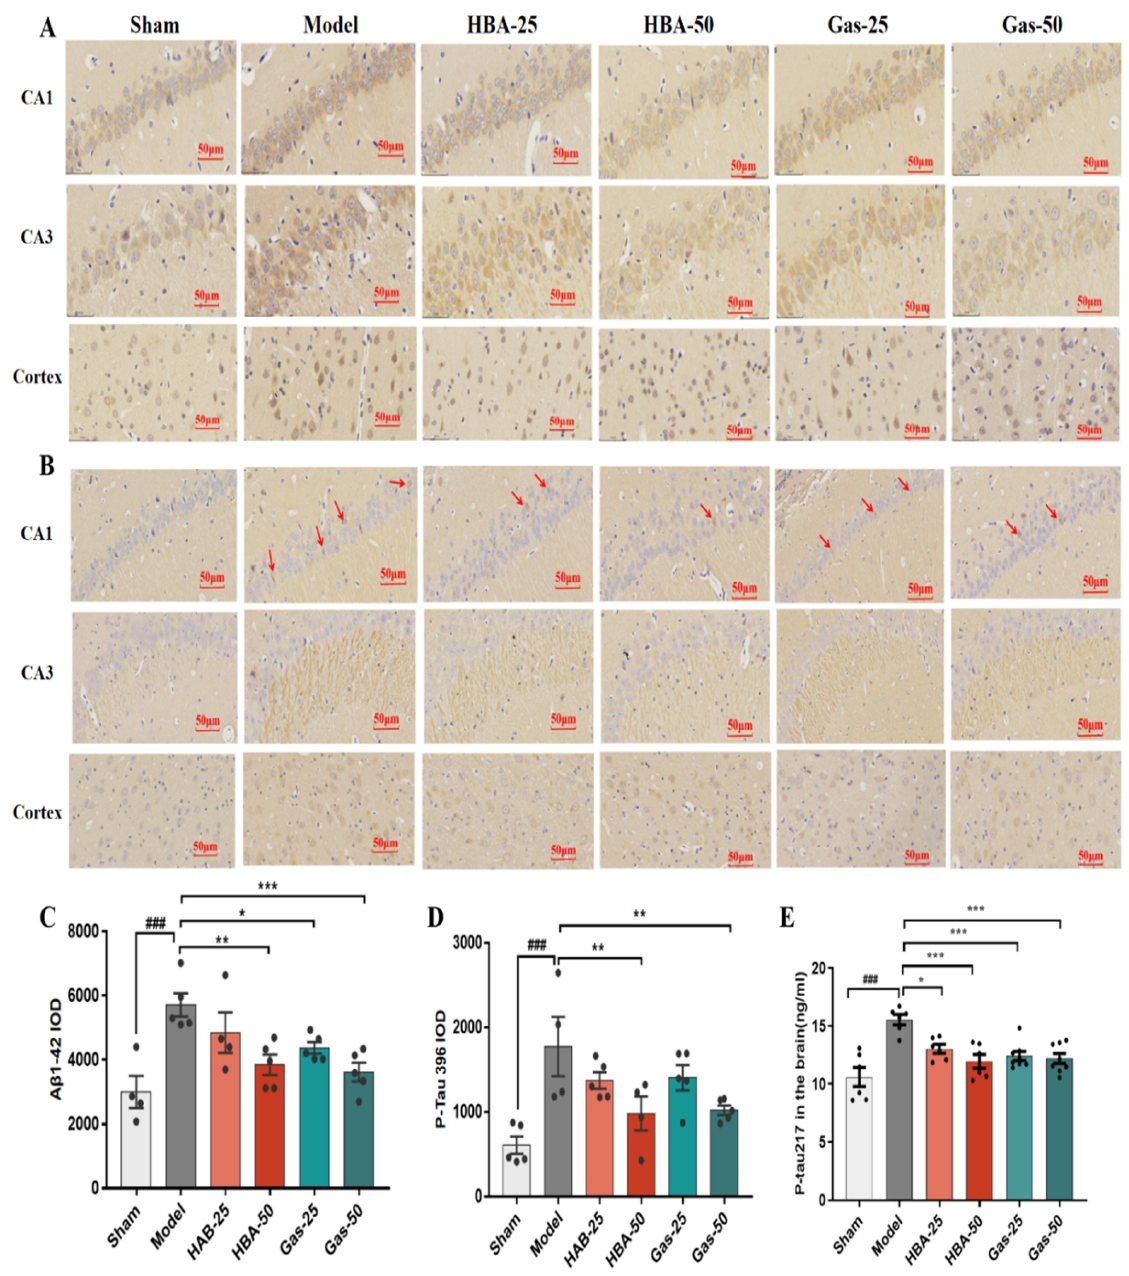
Figure 3. Effect of Gas and HBA on A β 1-42 and p-tau217 protein expression in CA1, CA3 region, and hippocampus cortex. ( A , C ) Representative IHC images and statistical histograms of A β 1-42; ( B , D ) Representative IHC images and statistical histograms of p-tau217, red arrows point to positive cells; ( E ) Protein concentration of p-tau217 in brain tissue homogenates. IOD values are expressed as mean ± SEM, ### p < 0.001 vs. Sham, * p < 0.05, ** p < 0.01, *** p < 0.001 vs. Model.